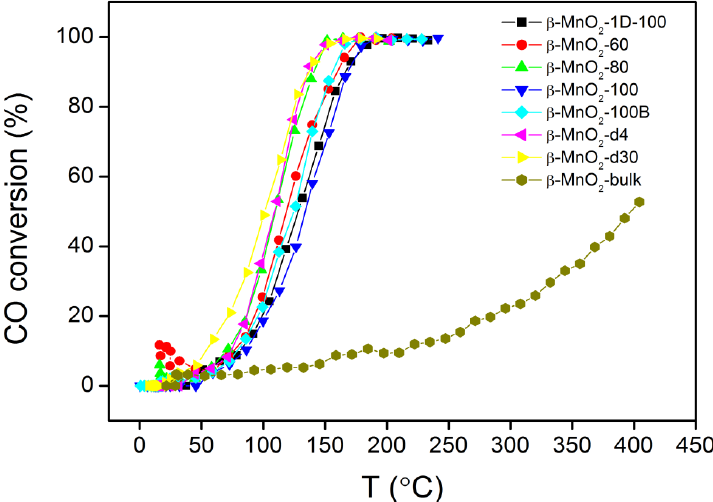
samples. Catalyst weight: 50 2